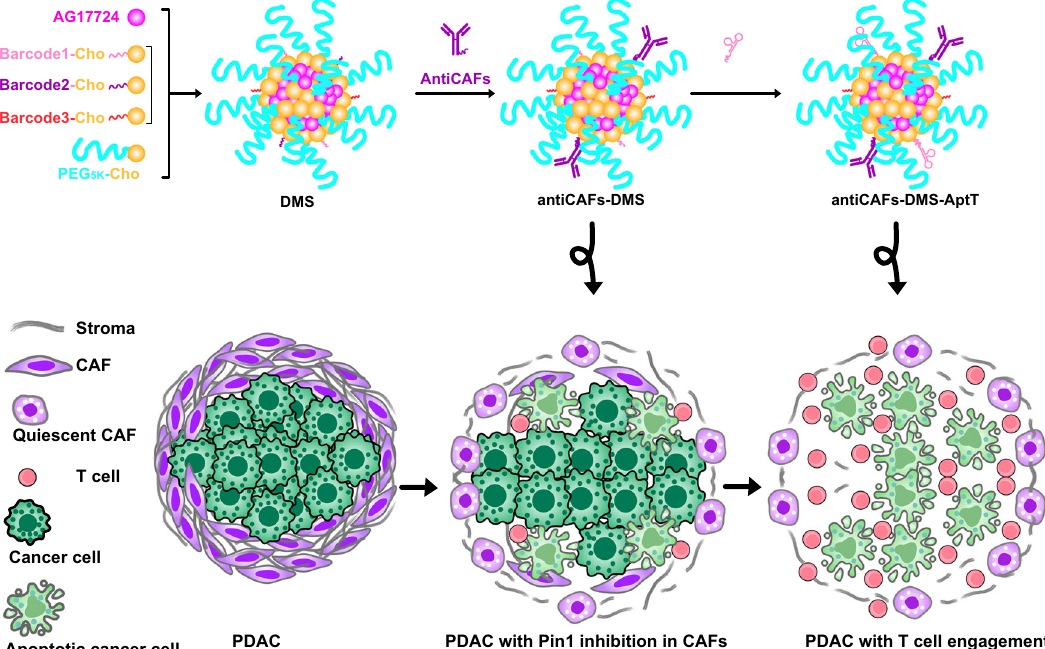
Fig. 1 | Schematic illustrationofantiCAFs-DMS andantiCAFs-DMS-AptTfor selective deliveryof PIN inhibitor to CAFs and then directing T Lymphocytes to